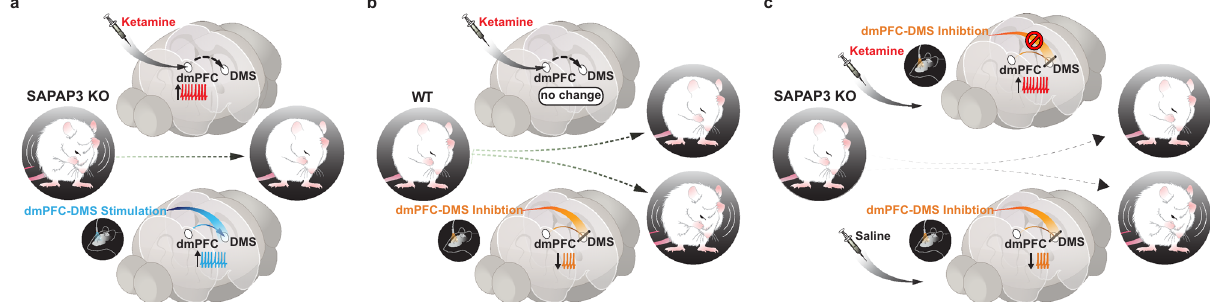
Fig. 8 Increasing dmPFC-DMS projection neuron activity via ketamine or optogenetic stimulation rescues compulsive grooming behavior. Graphical summary of the paper showing: a Ketamine produces a decrease in grooming behavior that is correlated with an increase in dmPFC-DMS projection neuron activity in SAPAP3 KO mice. This rescue of compulsive grooming behavior is causally reproduced by selectively stimulating dmPFC-DMS projection neurons. b Ketamine has no effect on grooming behavior or dmPFC-DMS circuit activity in WT mice, though optogenetic inhibition of dmPFC-DMS projections in WT mice was suf fi cient to induce increased grooming. c Ketamine blocks the increase in grooming behavior induced by optogenetic inhibition of dmPFC-DMS projection in